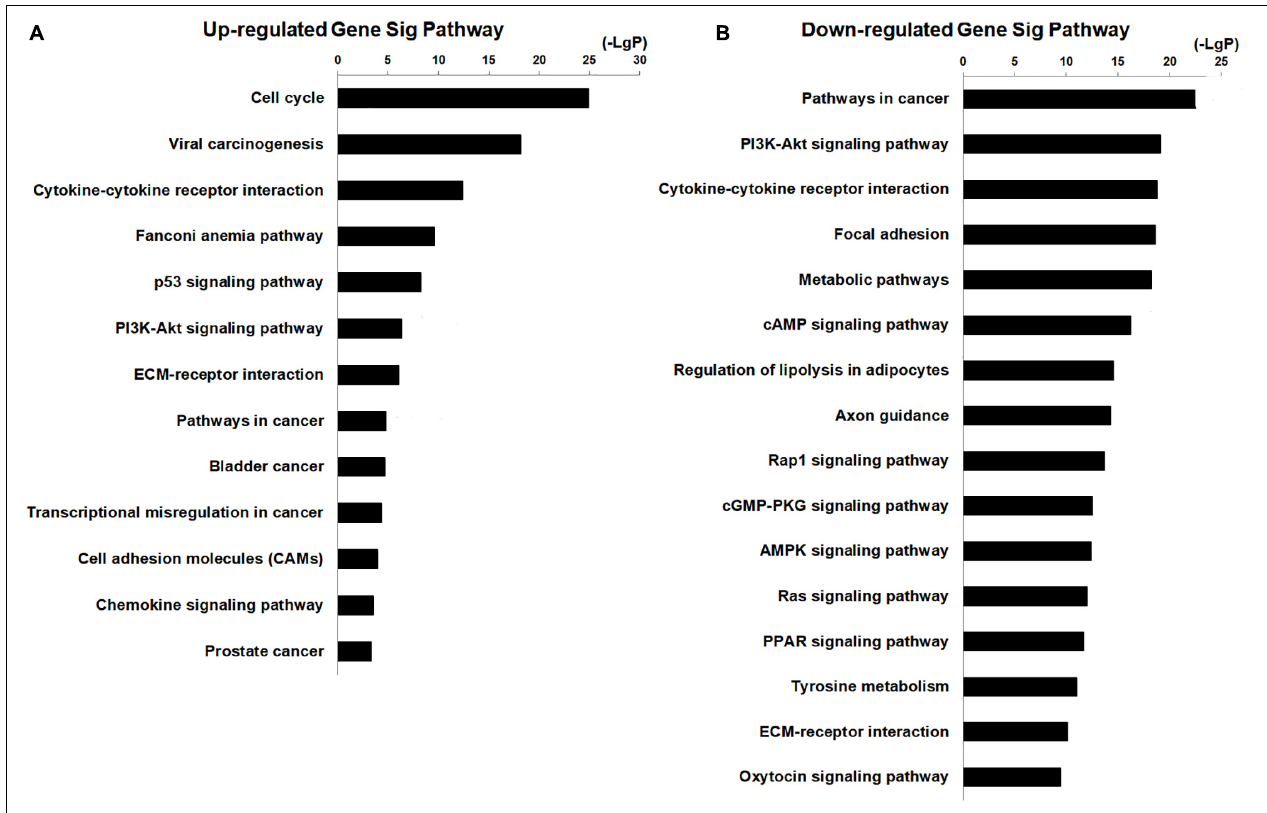
FIGURE 2 | KEGG pathway analysis for aberrantly expressed mRNAs in the progression of breast cancer. (A) Thirteen significant pathways in the top 20 upregulated genes. (B) Sixteen pathways in the top 20 downregulated genes.